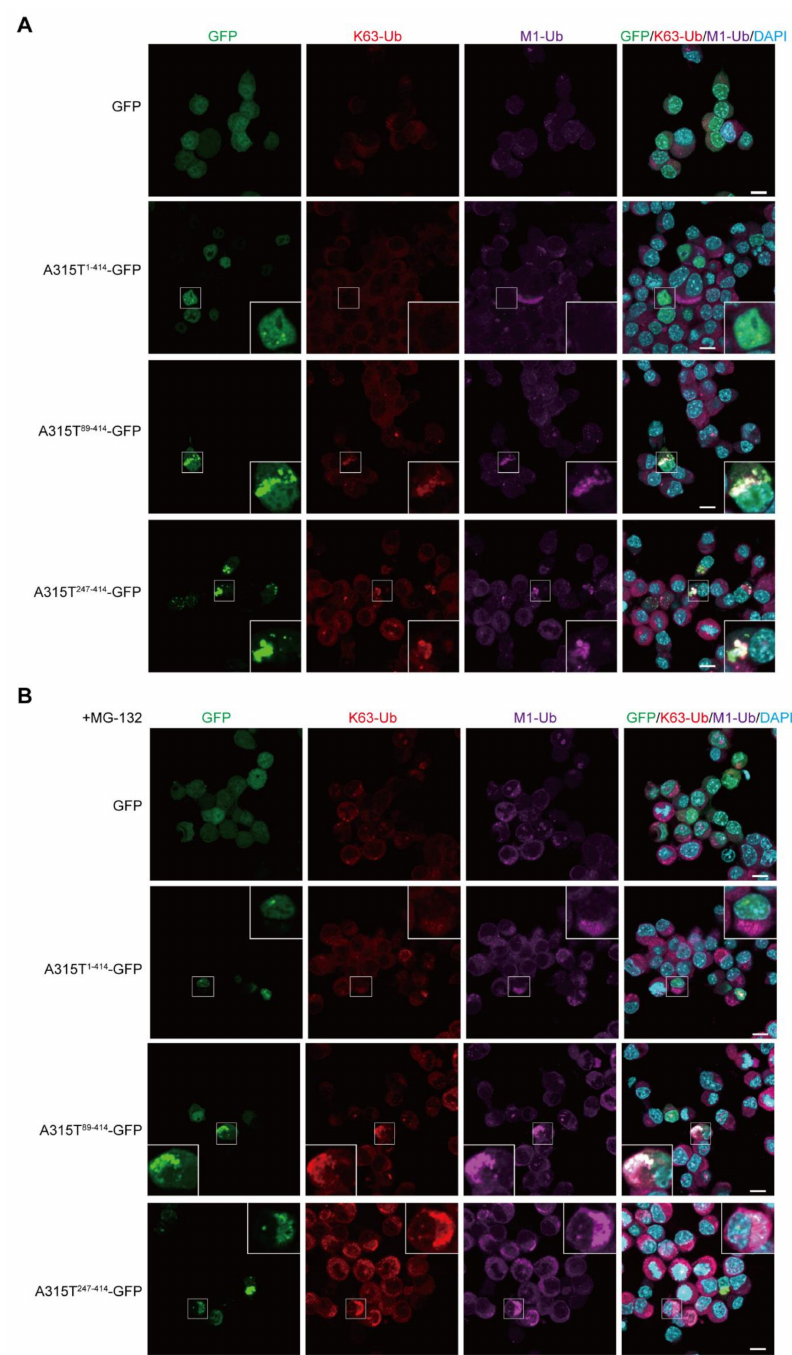
Figure 3. Cytoplasmic aggregates of truncated TDP-43 include K63- and M1-ubiquitins. ( A ) GFP and various A315T mutants of TDP-43-GFP were transiently expressed in Neuro2a cells, and the colocalization of K63-ubiquitin (K63-Ub) and linear ubiquitin (M1-Ub) was examined. ( B ) Similar experiments in ( A ) were performed after a treatment with 2 µ M MG-132 for 6 h. Bars = 10 µ